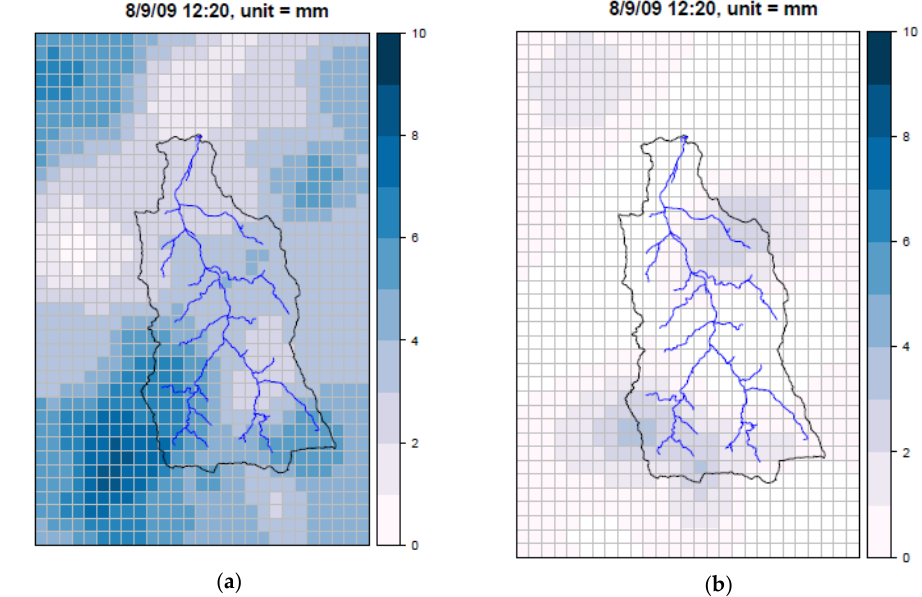
Figure 4. ( a ) Sample plot showing a trend surface of the QPESUMS rainfall distribution, and ( b ) sample plot of the residual surface of rainfall variation, based on radar data from Typhoon Morakot in August